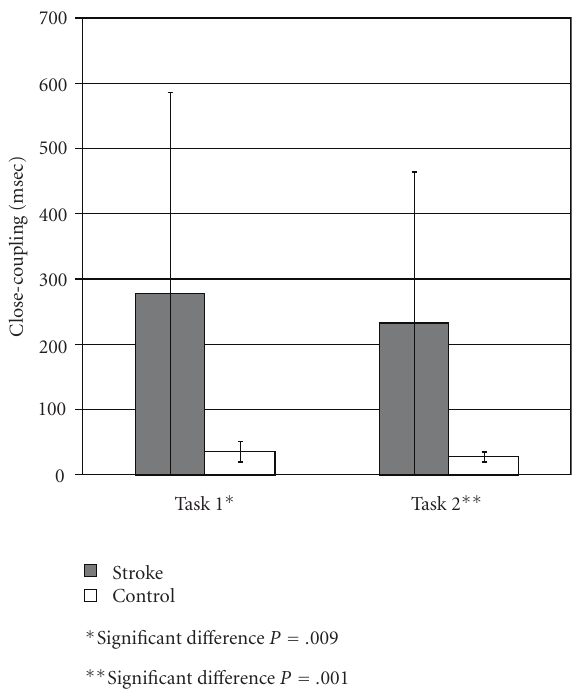
Figure 5: Comparison Of Close-Coupling For Stroke And Control